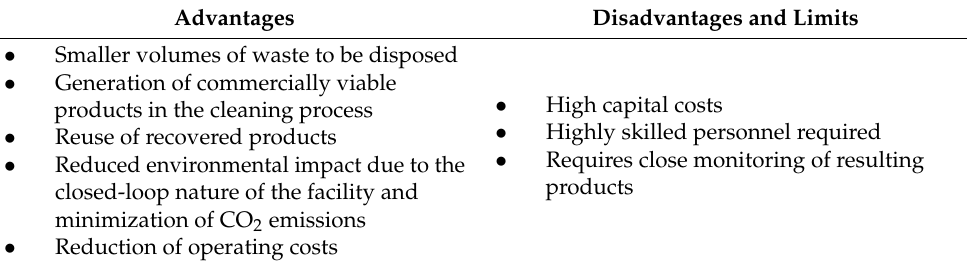
Table 8. Advantages and disadvantages of the TCC method